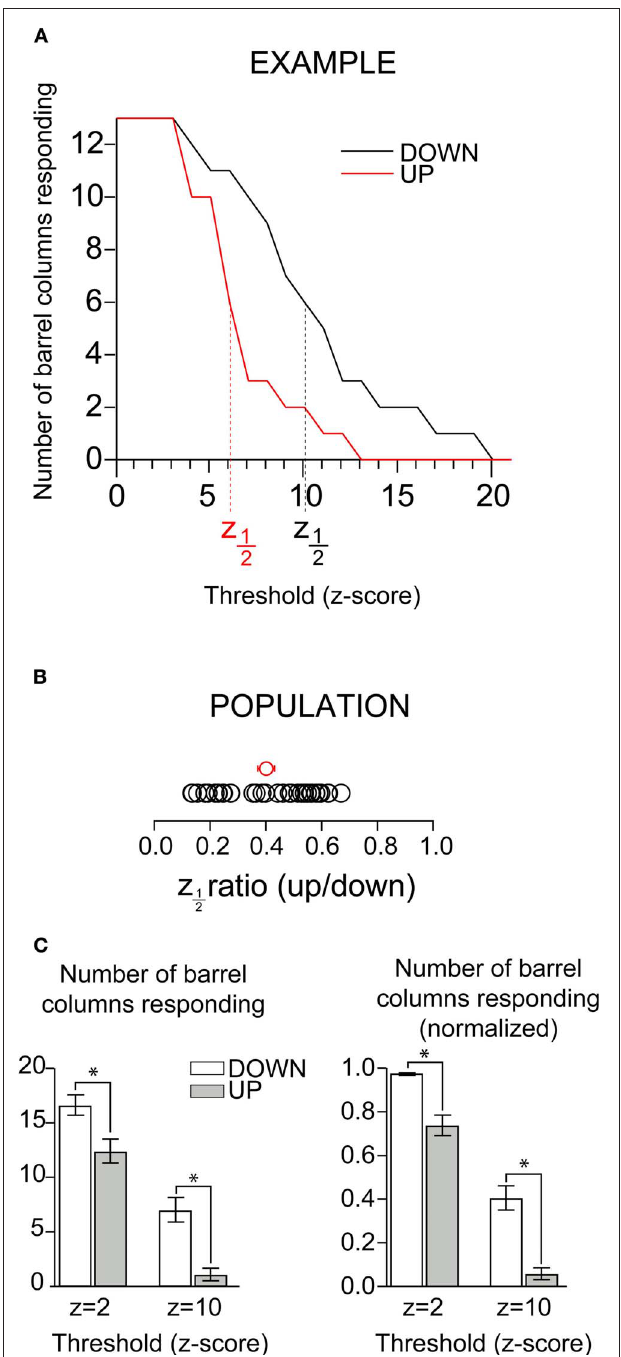
FIGURE 5 | Columnar extent of depolarizing responses in up and down-states. (A) Count of participating barrels as a function of chosen fluorescence ( z -score) threshold for down-(black) and up-(red) states in an example experiment. Vertical dotted line indicates a z 1 / 2 of 1. (B) Up-state z 1 / 2 values for all experiments (each normalized to the corresponding down-state); red dot indicates mean. (C) Raw (left) and normalized (right) column counts for minimal response ( z = 2) and large response ( z = 10) thresholds in up- and down- states. Statistically significant differences between up and down-state counts (Wilcoxon Signed Rank Test, p < 0 . 01) are indicated with the ∗